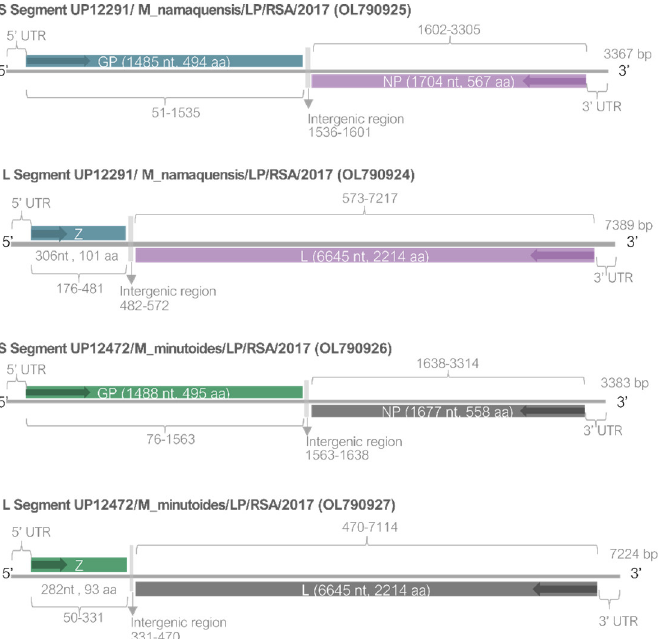
Figure 2. Gene organization of genome segments of arenaviruses detected in Limpopo, South Africa. Positions of open reading frames are given, including intergenic loop regions, sizes of Glycoprotein (GP), Nucleoprotein (NP), Zinc-binding protein (Z), and RNA-directed RNA polymerase (L) genes as nucleotides (nt) and amino acids (aa). Table 2. Similarities between reference species and genomes identified in this